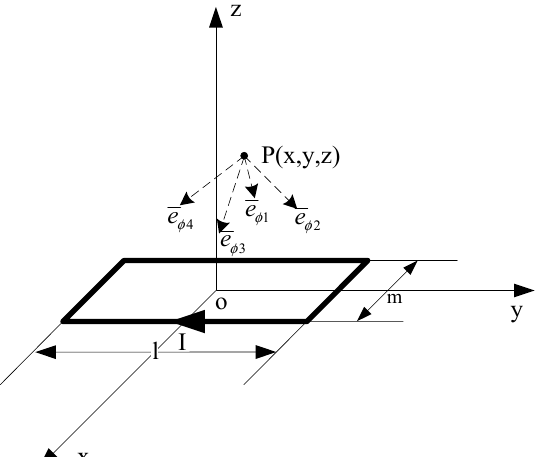
Figure 11. The magnetic flux density of square current-carrying